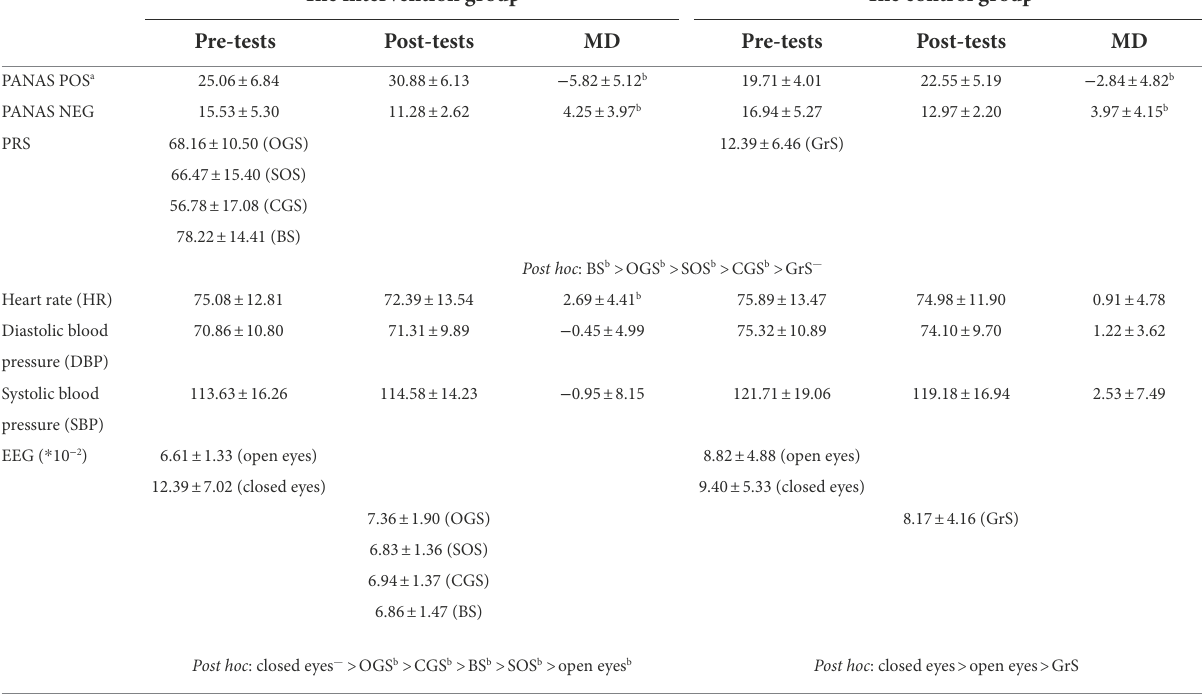
TABLE 3 The results of the T -test and ANOVA (mean values ± standard deviation) concerning the effects of one visual stimulation on psychological and physiological restorative indicators of patients and the differences between the two